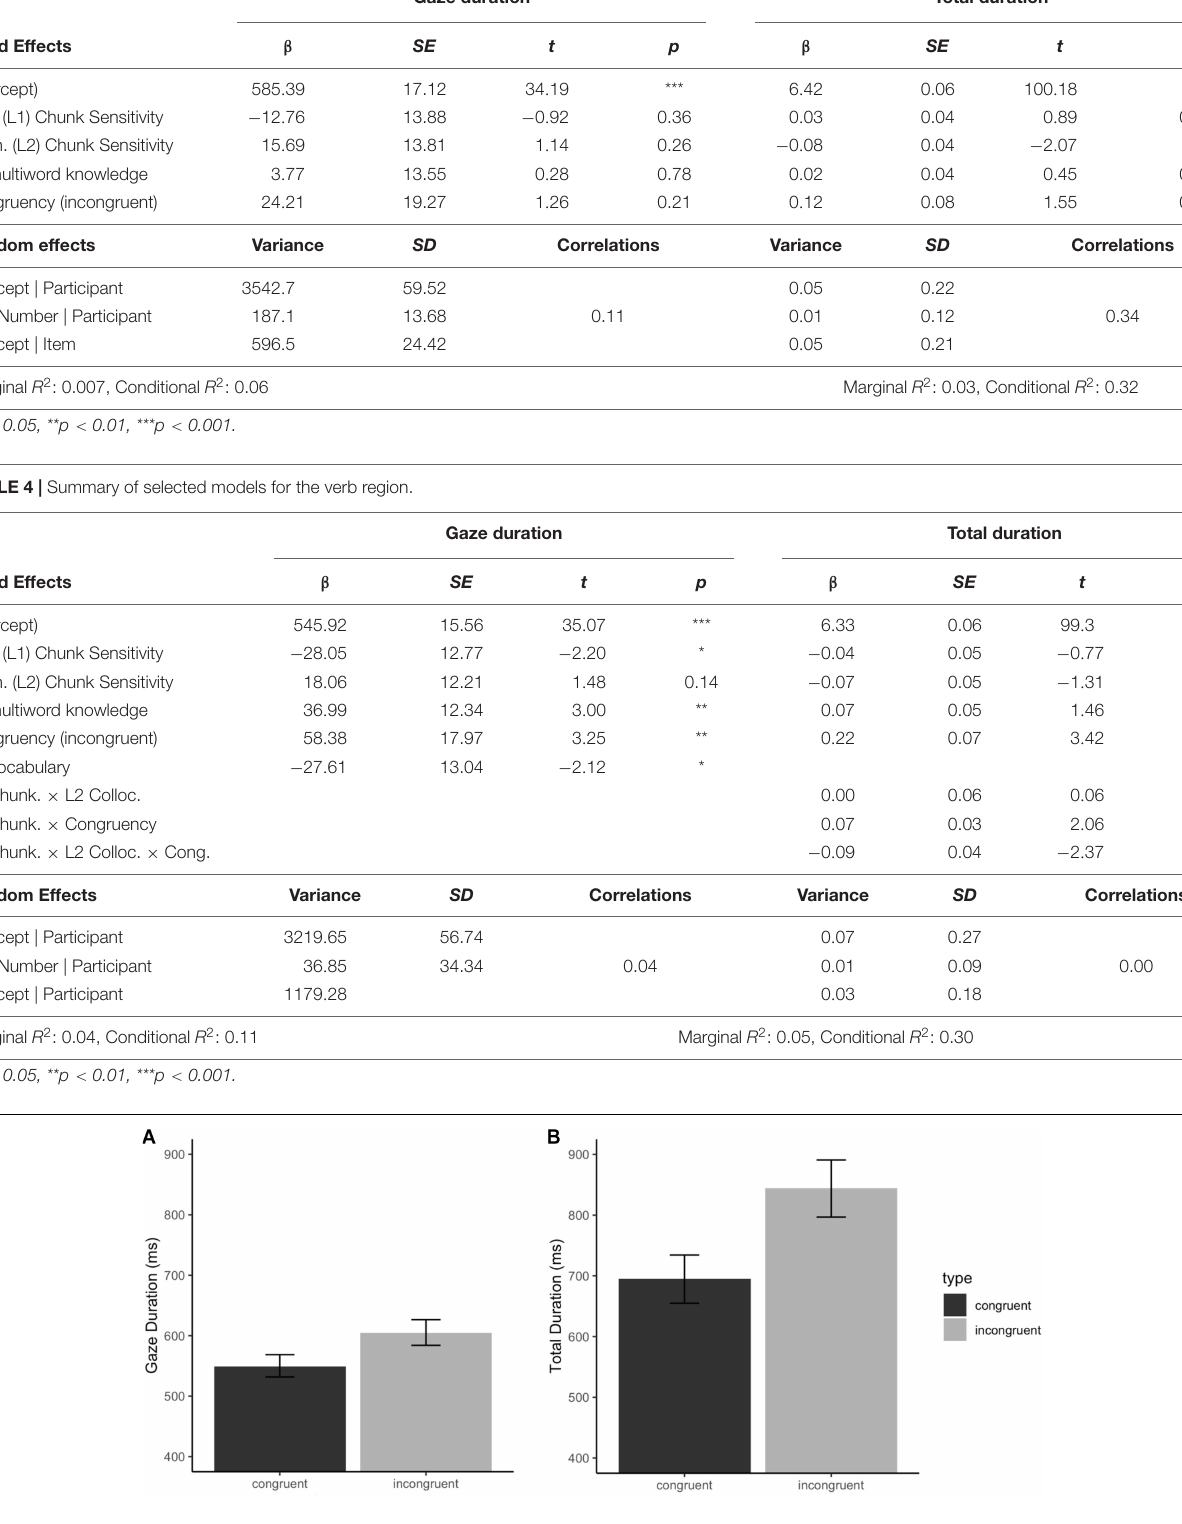
FIGURE 2 | Effect of L1-L2 congruency of the verb on (A) gaze duration and (B) total duration reading times of the verb region. Error bars represent the 95% CI.